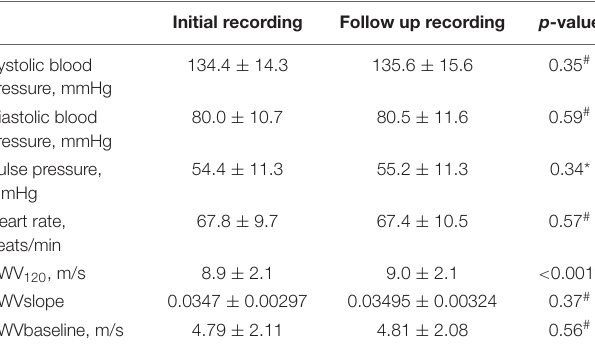
TABLE 4 | Comparison between initial and follow-up recording ( n =